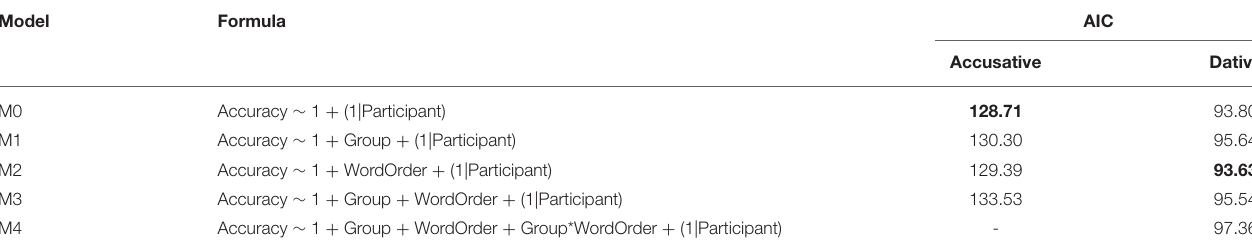
TABLE 3 | Model space for accuracy in the production task.